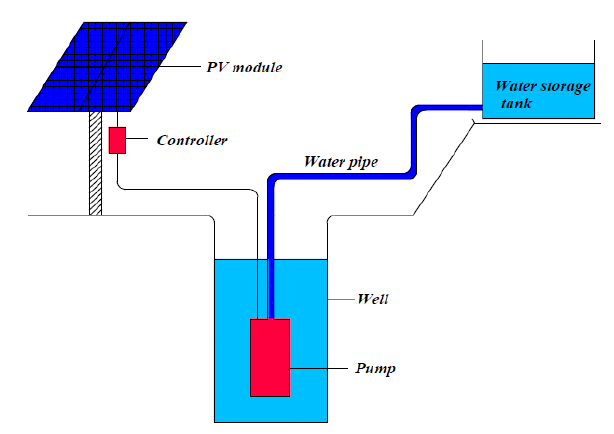
Fig. 3. Directly-coupled PV-pumping system